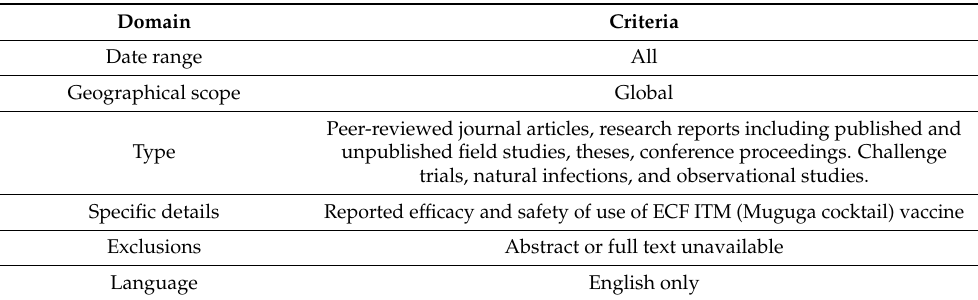
Table 3. Study selection criteria for ECF Muguga cocktail